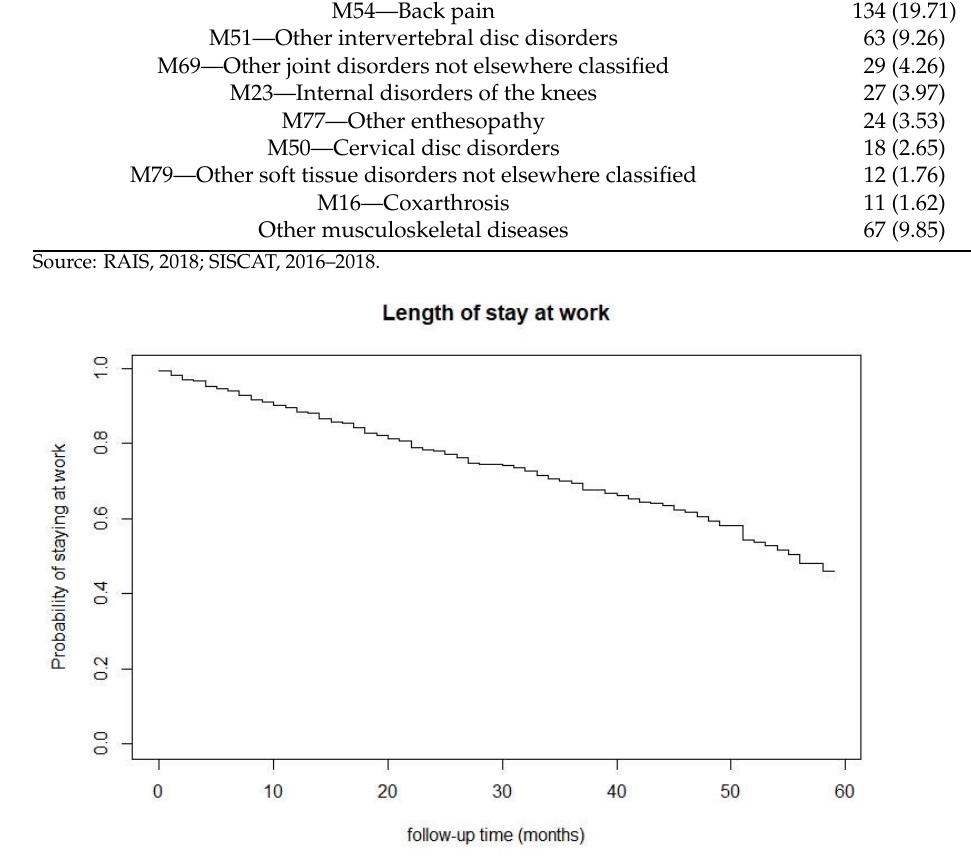
Figure 1. Probability of staying at work. Source: RAIS, 2018; SISCAT, 2016–2018. Table 4. Univariate and multiple analyses (Cox regression) on the length at stay at work among workers who underwent rehabilitation through Social Security due to WRMD disabilities, who then returned to the formal employment market. Brazil,